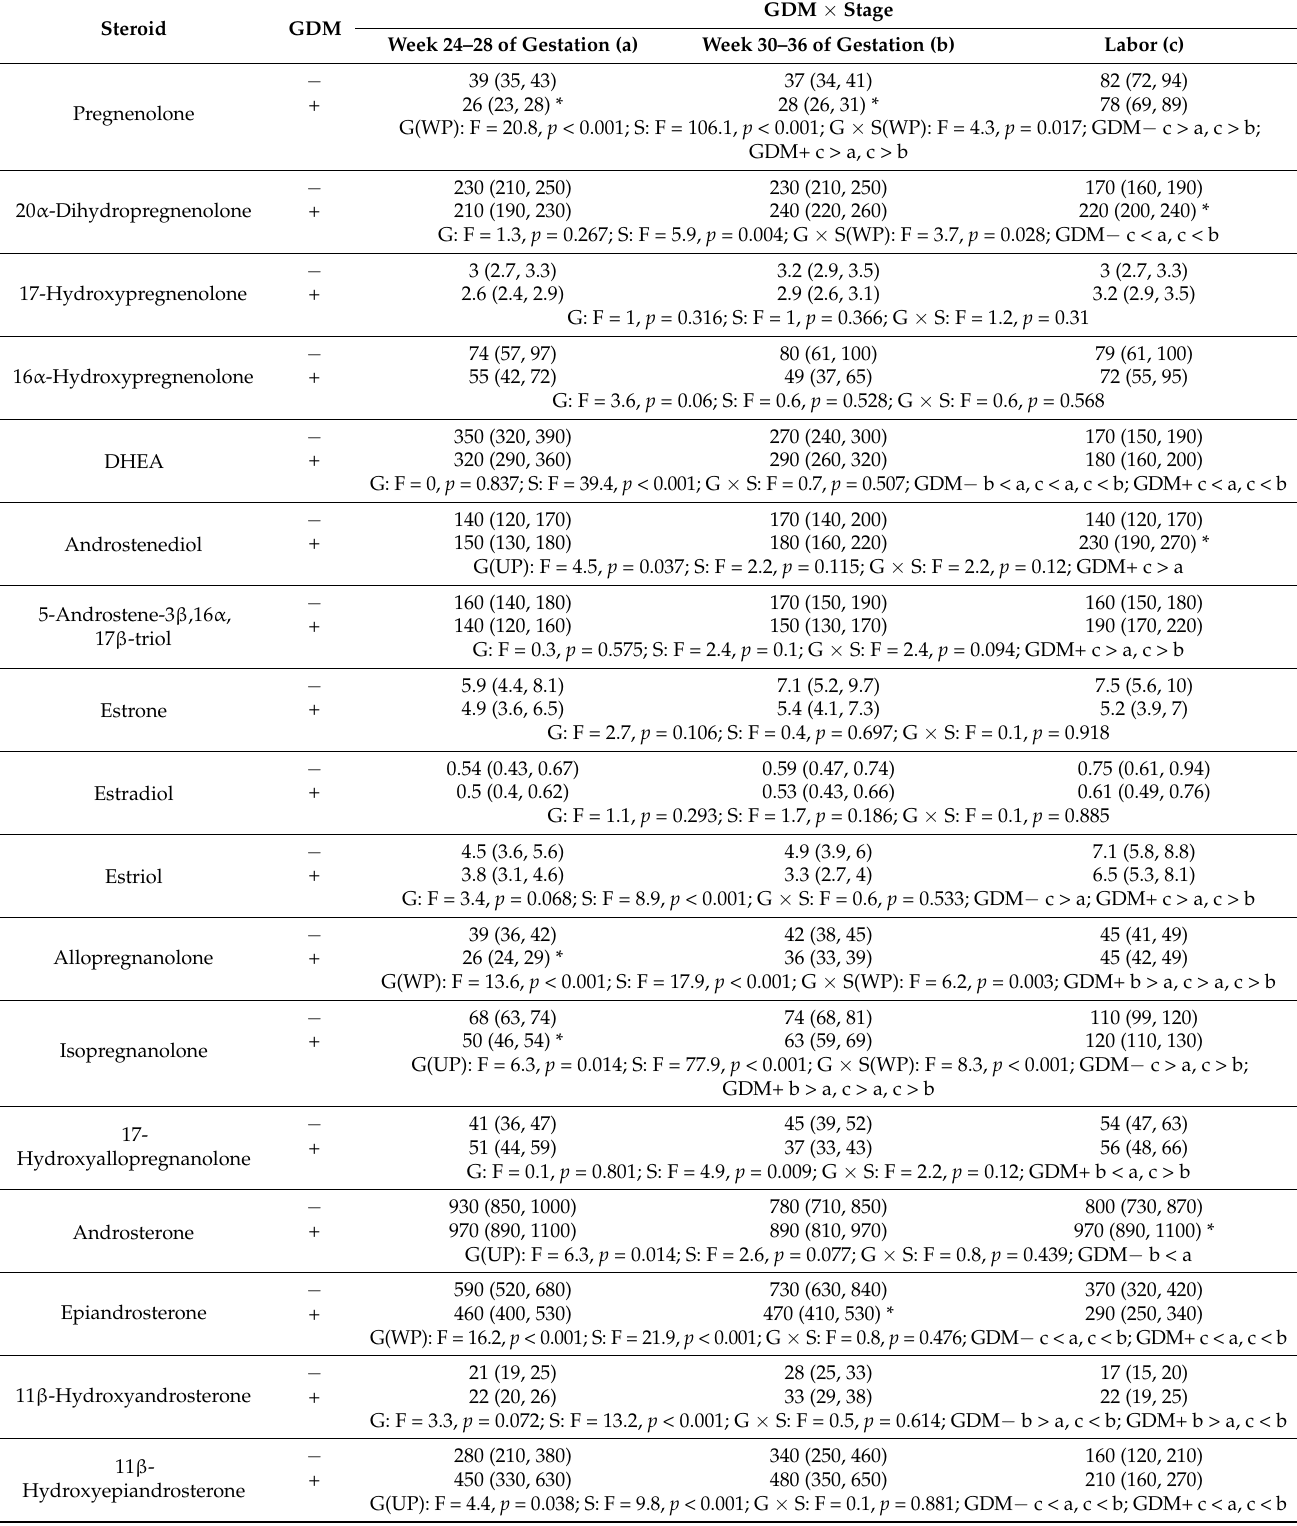
Table 6. Profiles of sulfated to unsulfated steroid ratios in the GDM − and GDM+ groups from week 24 of gestation to labor.